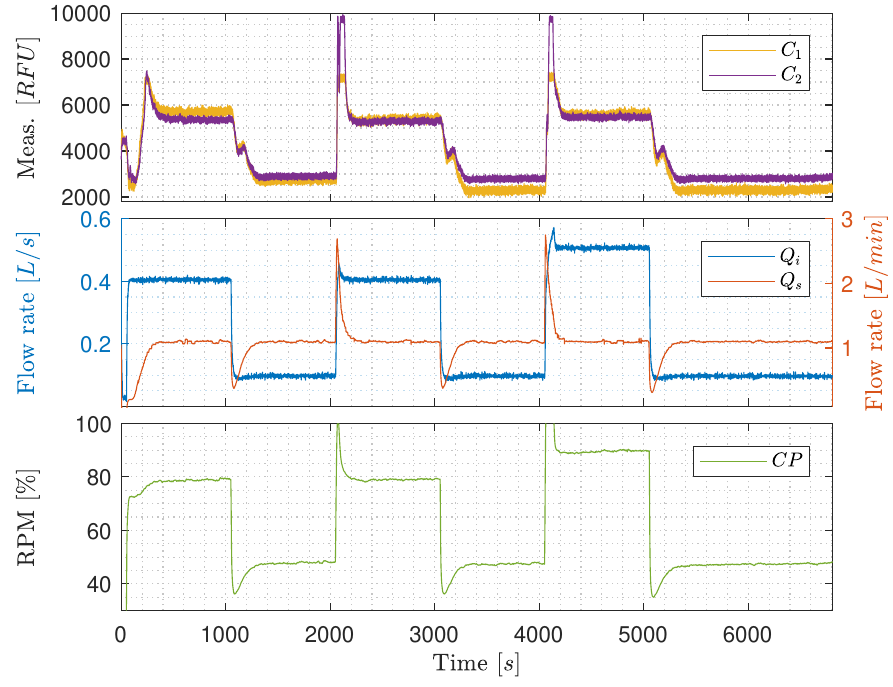
Figure 7. Q i ’s influence on C 1 and C 2